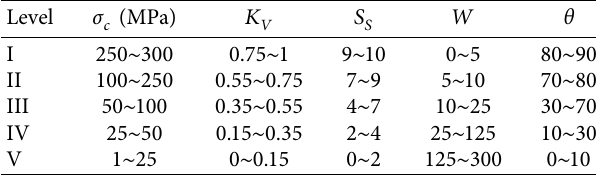
Table 1: The assessment standard of surrounding rock quality.